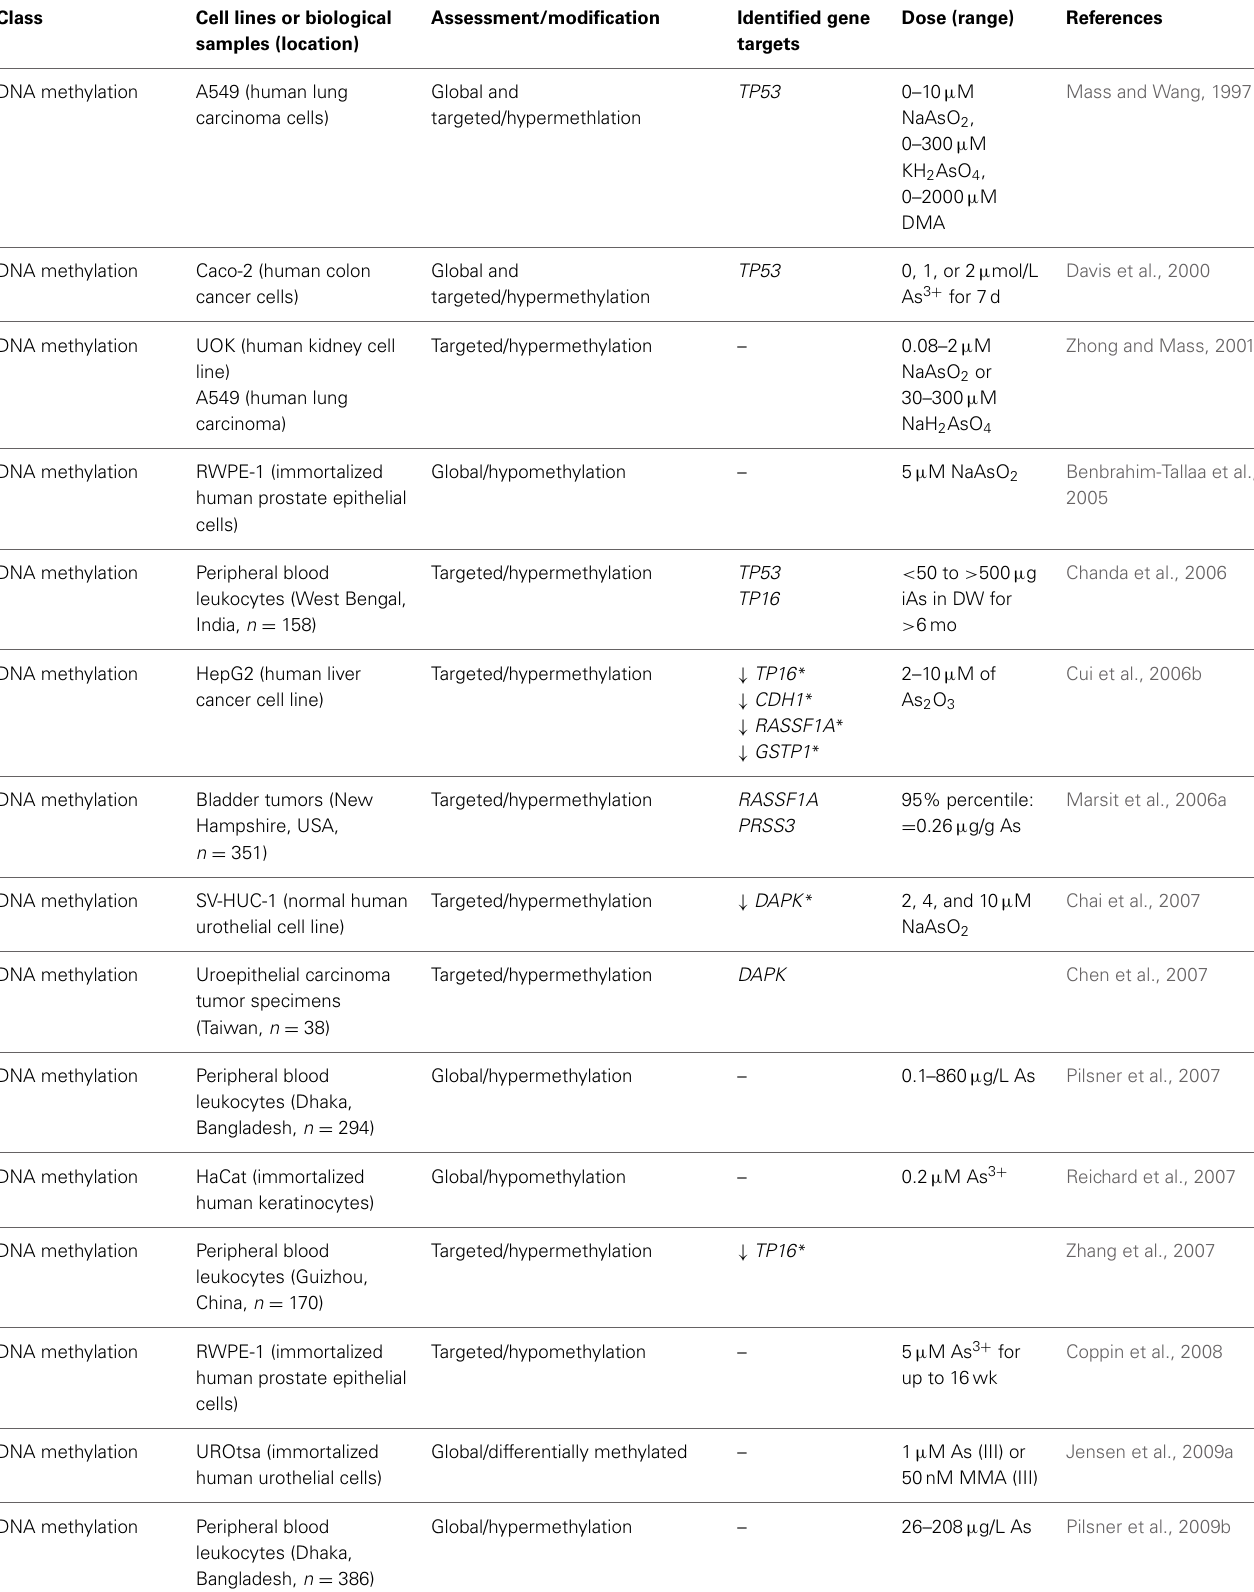
Table 1 | Epigenetic alterations induced by inorganic arsenic (iAs) or iAs